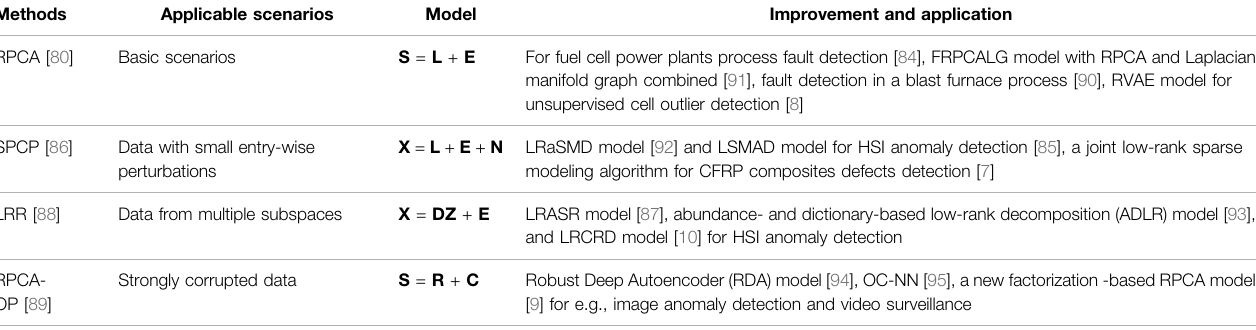
TABLE 2 | Matrix factorization method. Methods